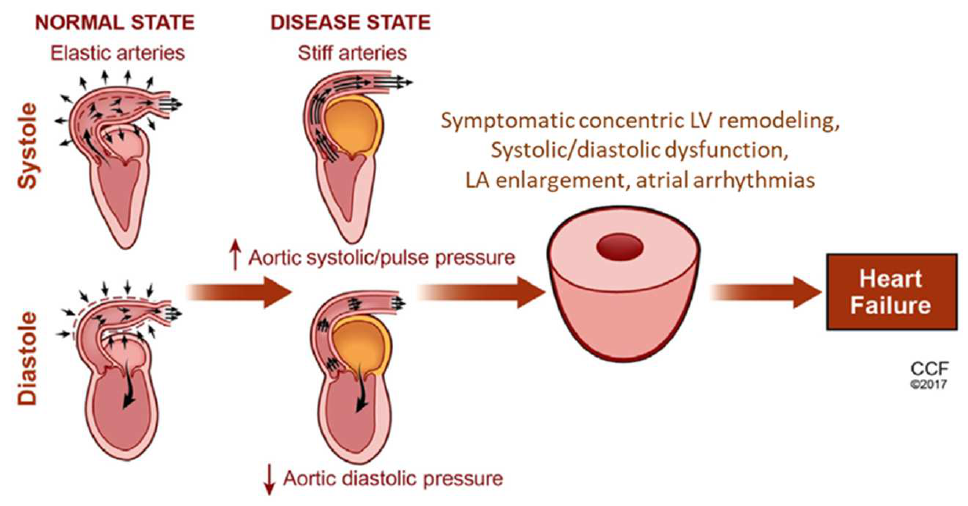
Figure 4. Effects of increased aortic stiffness on LV function and structure. LV, left ventricle; LA, left atrium; HF, heart failure. Reprinted with permission from Xanthopoulos A, Triposkiadis F and Starling RC. Heart failure with preserved ejection fraction: Classification based upon phenotype is essential for diagnosis and treatment. Trends Cardiovasc Med. 2018;28:392–400 [45]. Copyright © The Author(s) 2018. Trends in Cardiovascular Medicine published by Elsevier.